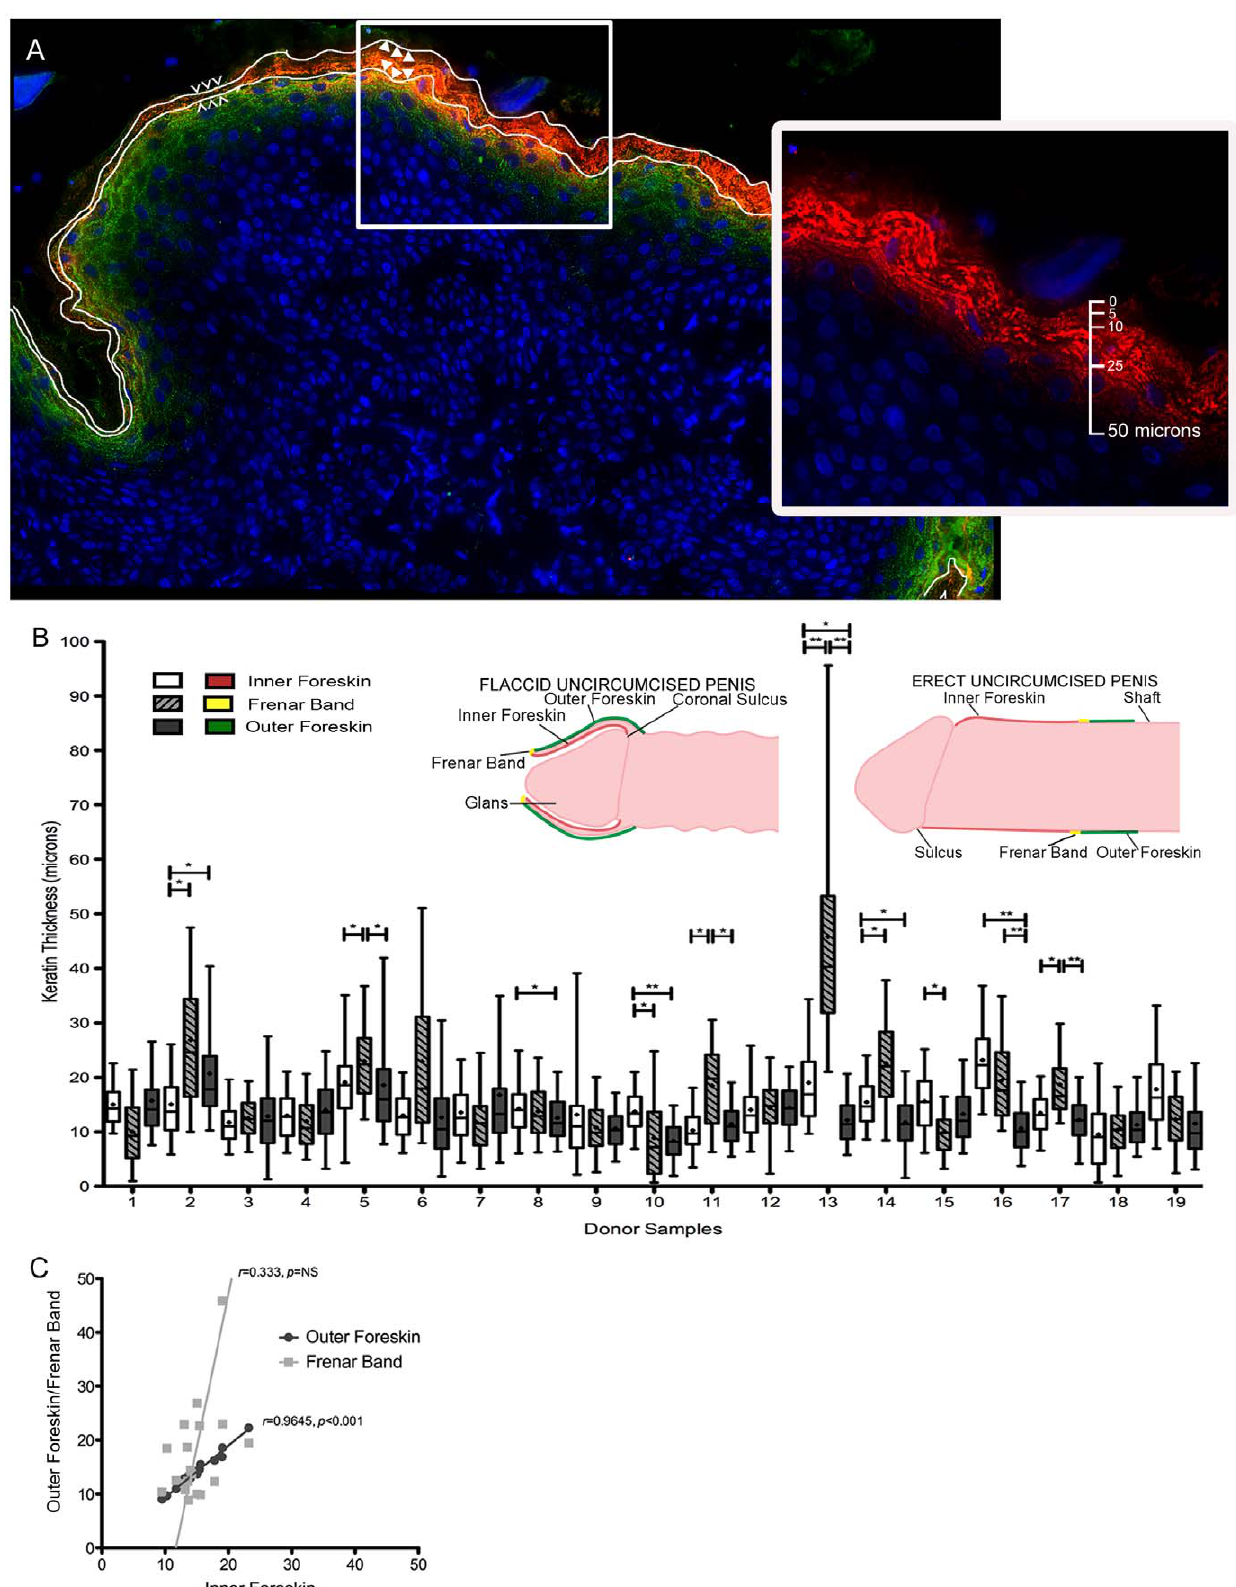
Figure 1. Mean foreskin keratin thicknesses by donor and region. (A) Representative image of intra-individual variation in keratin thickness (outer foreskin). White ‘ VVV ’ symbols show areas of thinner keratin and white solid triangles show areas of thicker keratin. Involucrin (green), filaggrin (red), cell nuclei (blue). Inset: magnification of boxed area with only filaggrin staining (red) shown; scale depicts thickness in microns. (B) Illustration of